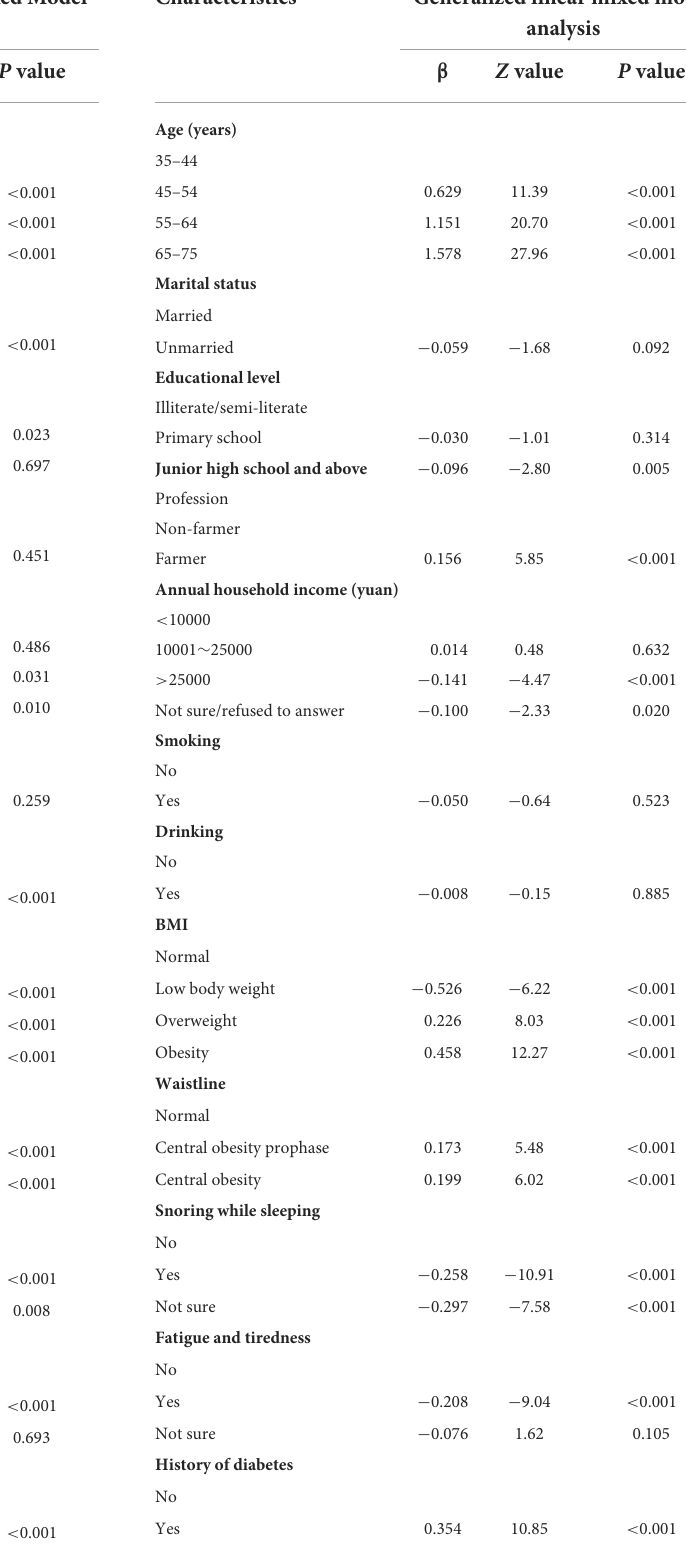
TABLE 5 Generalized Linear Mixed Model analysis of influencing factors among high-risk groups of CVD in